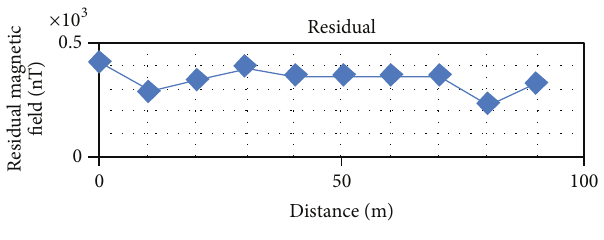
Figure 13: Profile